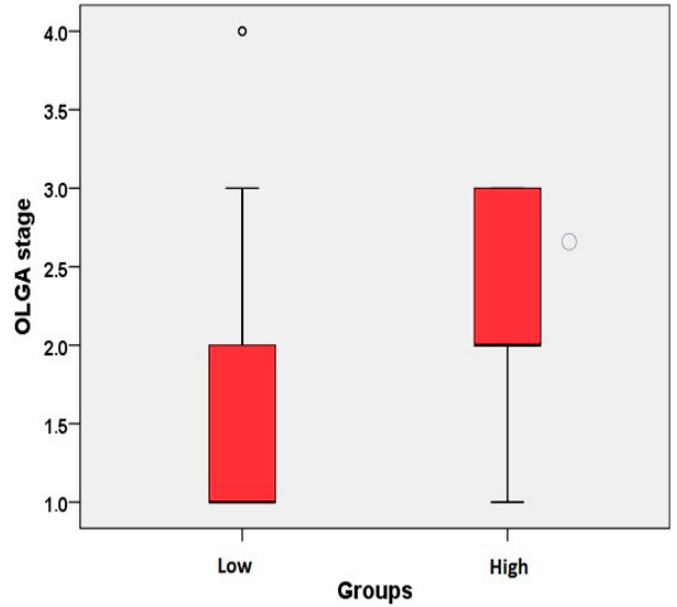
Figure 3. Comparison of the OLGA stage according to the neutrophil to lymphocyte ratio (NLR) and the NRS groups ( n = 14, n =